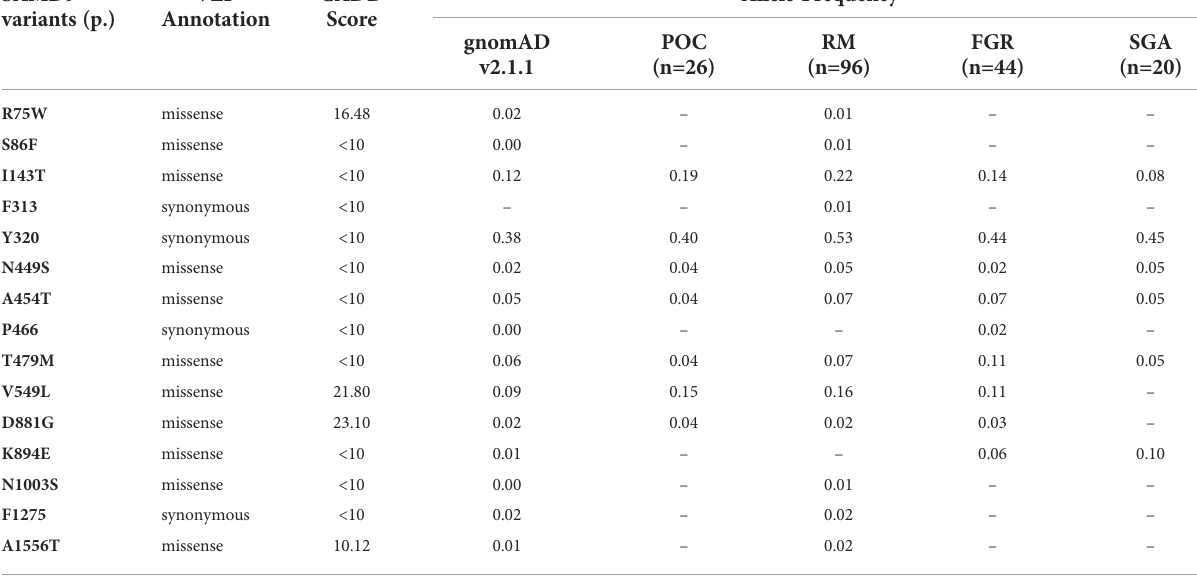
TABLE 2 SAMD9 allele frequency in the study cohorts. SAMD9 variants